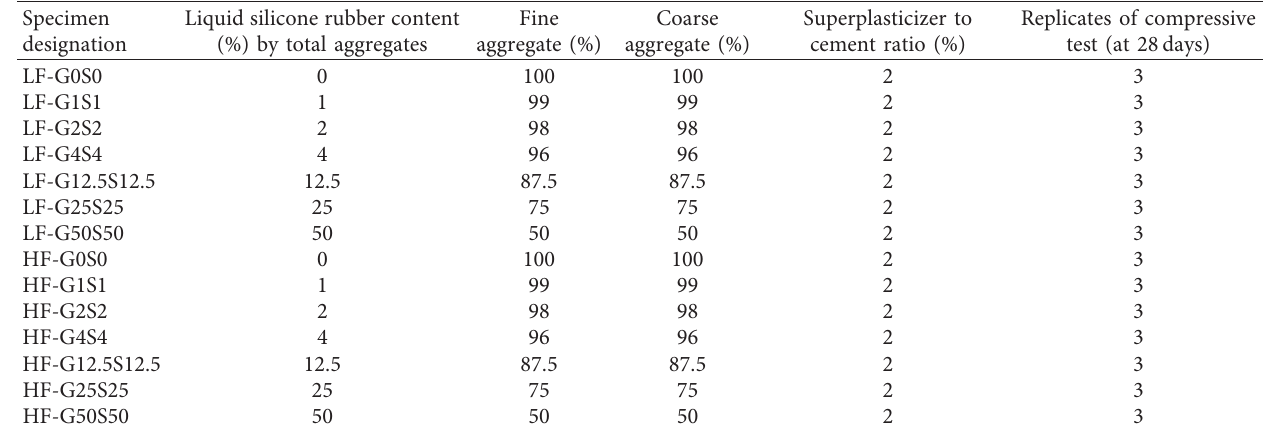
Table 3: Experimental program.